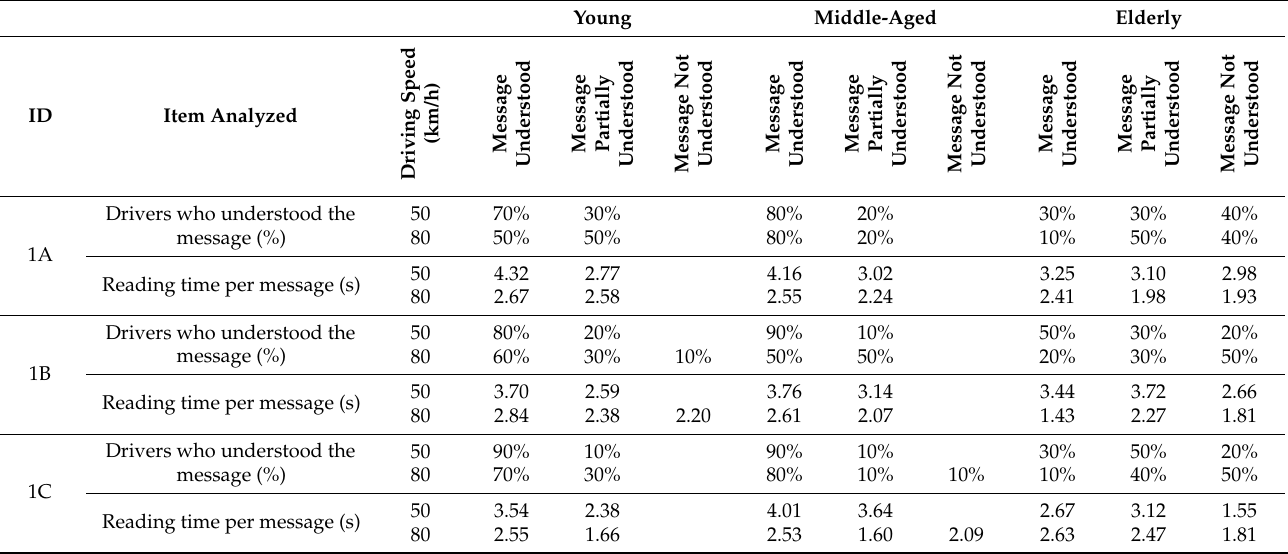
Table 4. Numerical results for Group 1—use of uppercase and lowercase